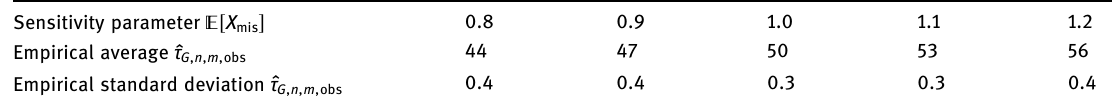
Table 4: Simulations results when applying procedure 3 : Results of the simulation considering X 1 being partially observed in the RCT, and using the sensitivity method of [ 35 ] , but with a Robinson procedure to handle semi - parametric generative functions. When varying the sensitivity parameters, the estimated ATE is close to the true ATE ( τ 50 = ) when the sensitivity parameter is closer to the true one ( X